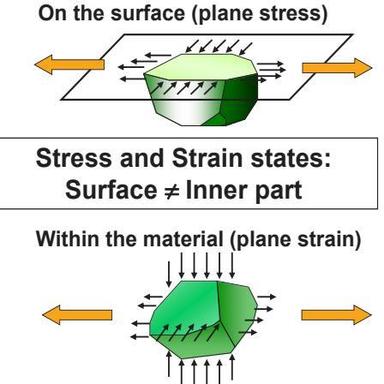
Difference of stress and strain states between surfaces and inside.